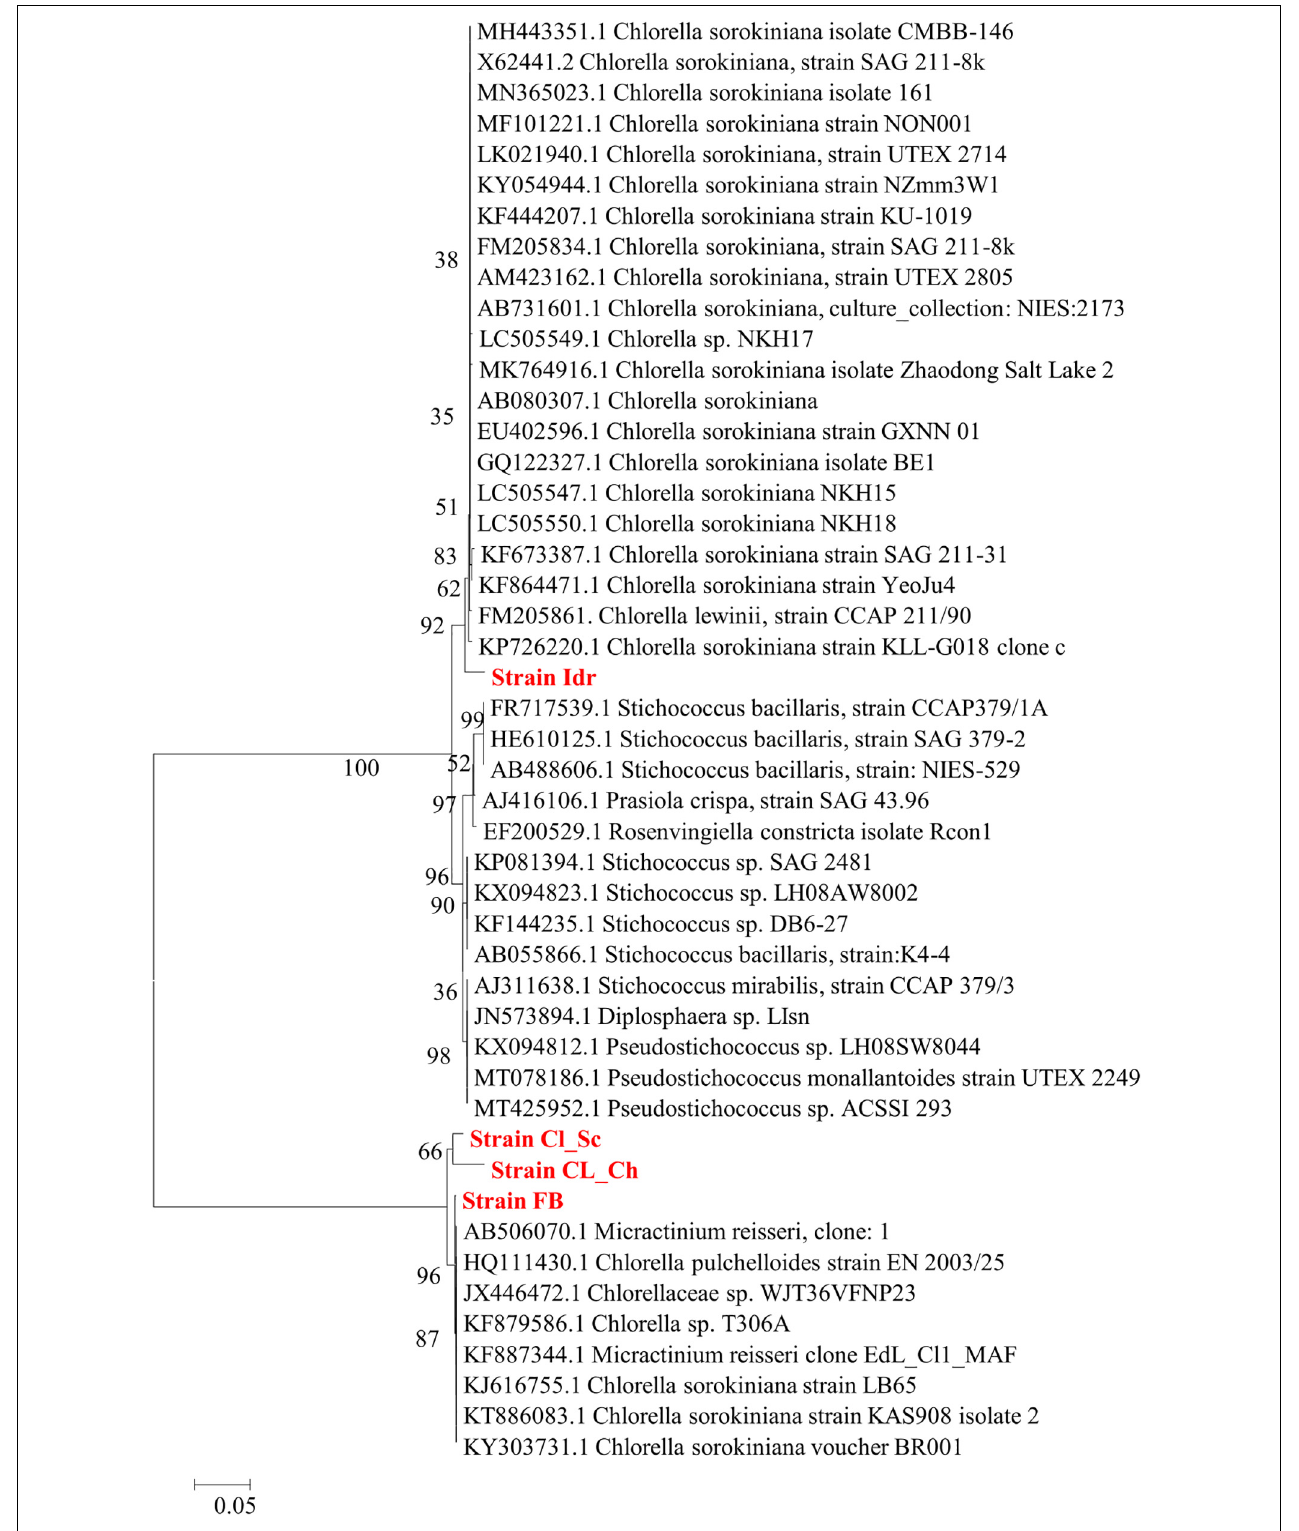
FIGURE 4 | Phylogenetic tree reconstruction obtained with Neighbor Joining method on a total of 43 high quality sequences selected from the most similar to the sequences obtained for the four strains analyzed in this work (Acc. N. MT992788-MT992791). Reconstruction was performed using Tamura-Nei Model, partial-deletion, Nearest-Neighbor Interchange Heuristic Method, and 500 bootstrap resampling to evaluate the robustness of the inferred trees.